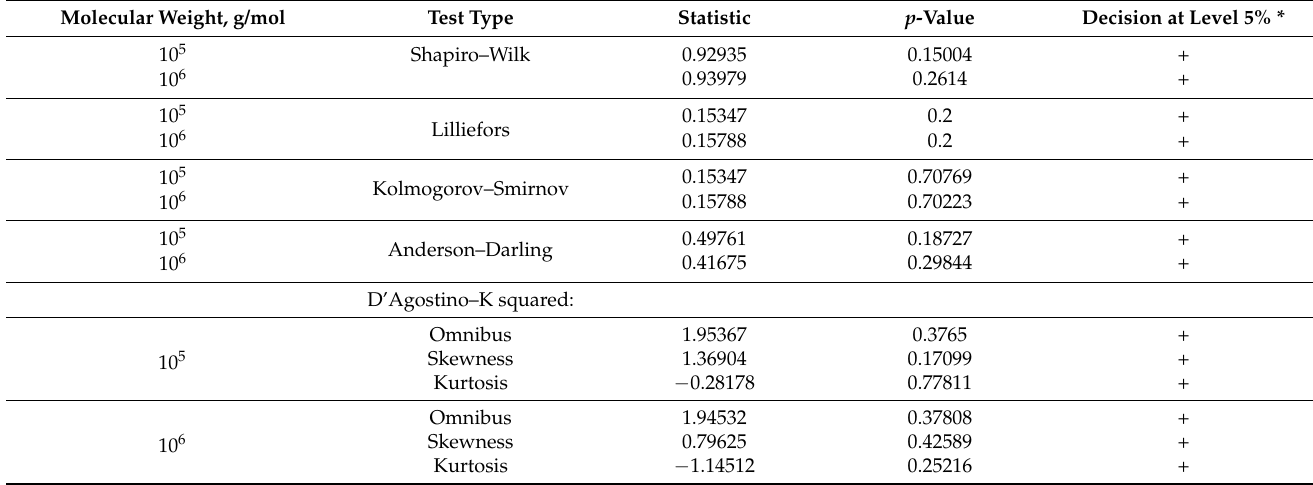
Table 1. Statistical parameters of the lap-shear strength distribution estimated for two PS–PS interfaces in five normality